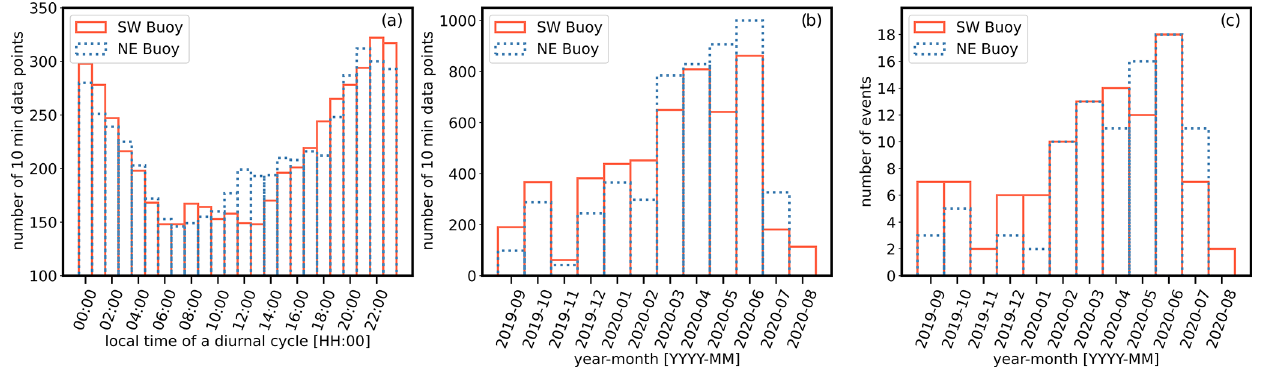
Figure 6. Diurnal and seasonal distribution of high-shear events at both buoys: number of 10min profiles in which high shear was detected as a function of local time (a) and month (b) and number of events across the year (c) .